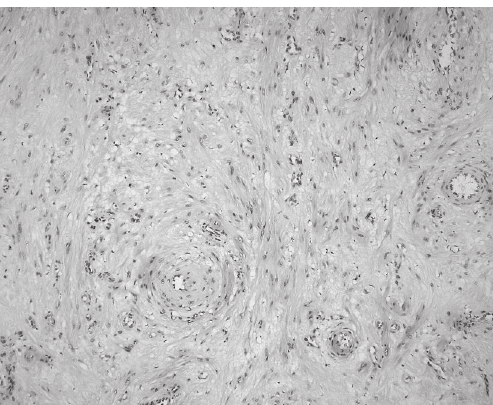
Figure 1: An MRI of the elbow showing a soft tissue tumour.